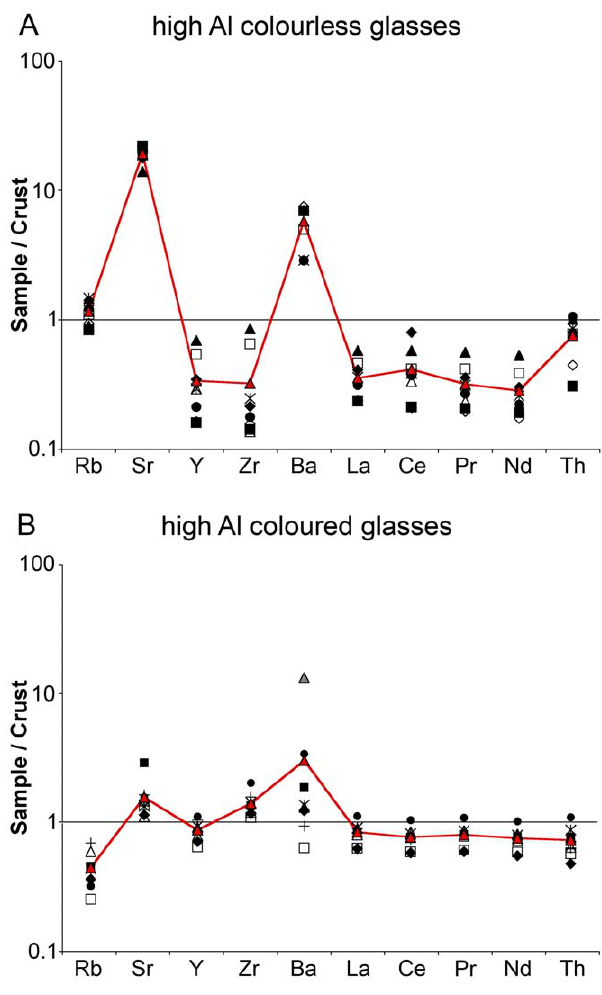
Figure 5. Trace element distributions of the high alumina glasses from Pergamon. (A) The trace element pattern of individual colourless and pinkish samples from Pergamon (black and open symbols) and the average concentration (red line) were normalised to the mean continental crust [43], and are displayed on a logarithmic scale. (B) Trace element distributions of the coloured high alumina glasses from Pergamon (black, grey and open symbols) and mean trace element pattern